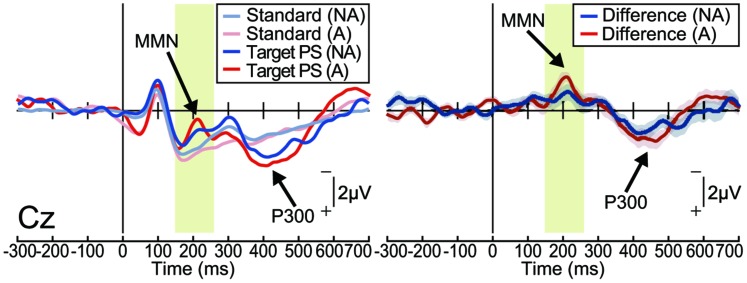
Pitch-deviant auditory feedback elicited MMN and P300 (Experiment 1). Left: the event-related potentials (ERPs) at Cz elicited by pitch-deviant stimuli presented passively (non-action condition; NA) or by a mouse-click performed by the participant (action condition; A; n = 16). Right: differential (target – standard) ERP waveforms. Shaded (blue or red) areas represent SEM. The MMN was observed around 200 ms from the stimulus onset, both in the non-action [t(15) = 4.84, P < 0.001, effect size r = 0.78] and action conditions [t(15) = 6.20, p < 0.001, effect size r = 0.85]. The P300 followed the MMN [non-action: t(15) = 9.07, p < 0.001, effect size r = 0.92; action: t(15) = 6.02, p < 0.001, effect size r = 0.84].